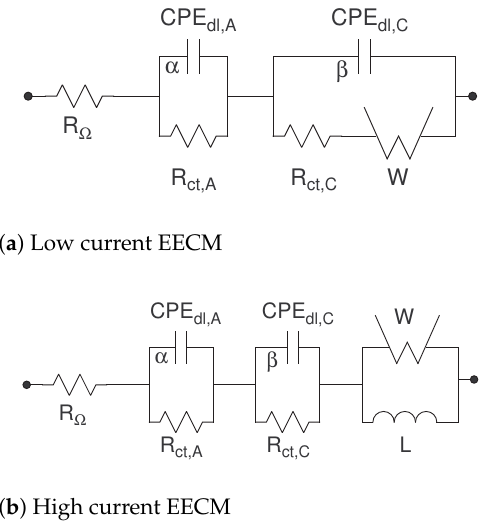
Figure 3. The Dhirde et al. [13] equivalent electric circuit